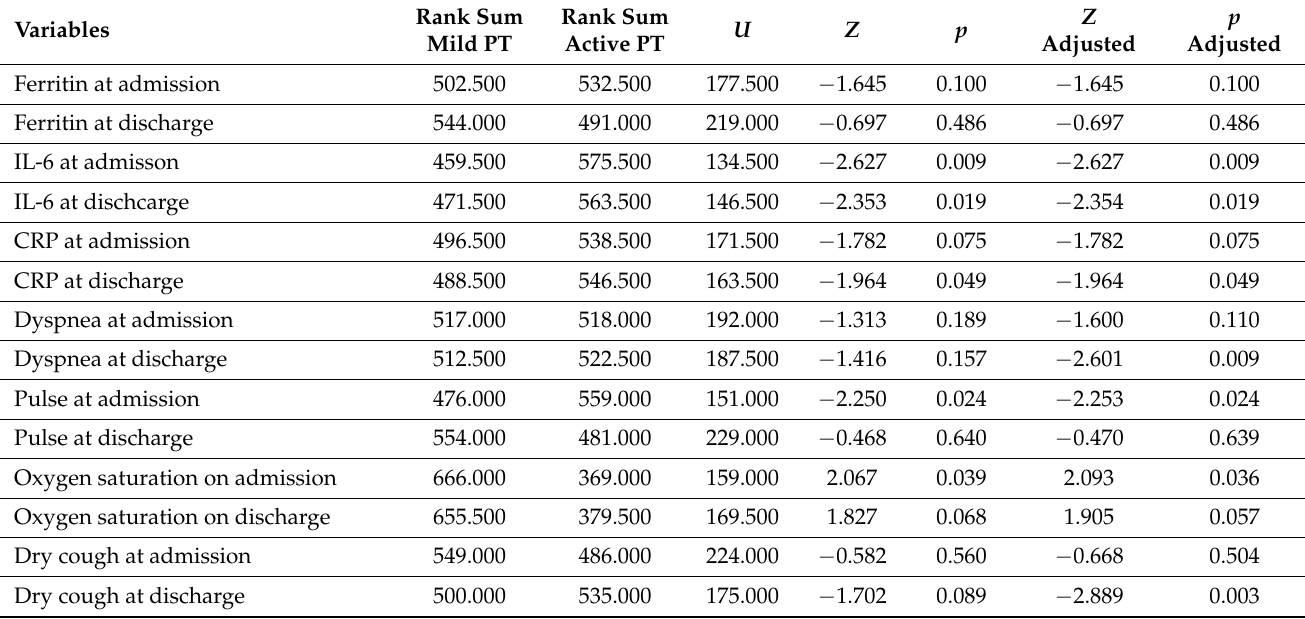
Table 5. Biological and clinical variables (mild vs. active physiotherapy).